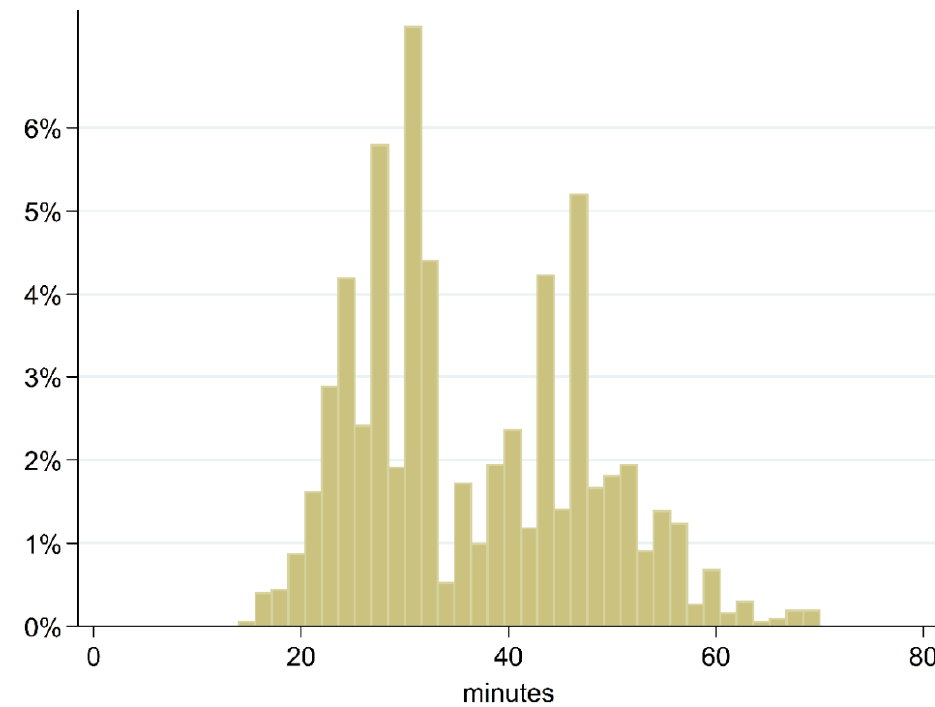
Figure 4. Distribution of the travel times to CBD.